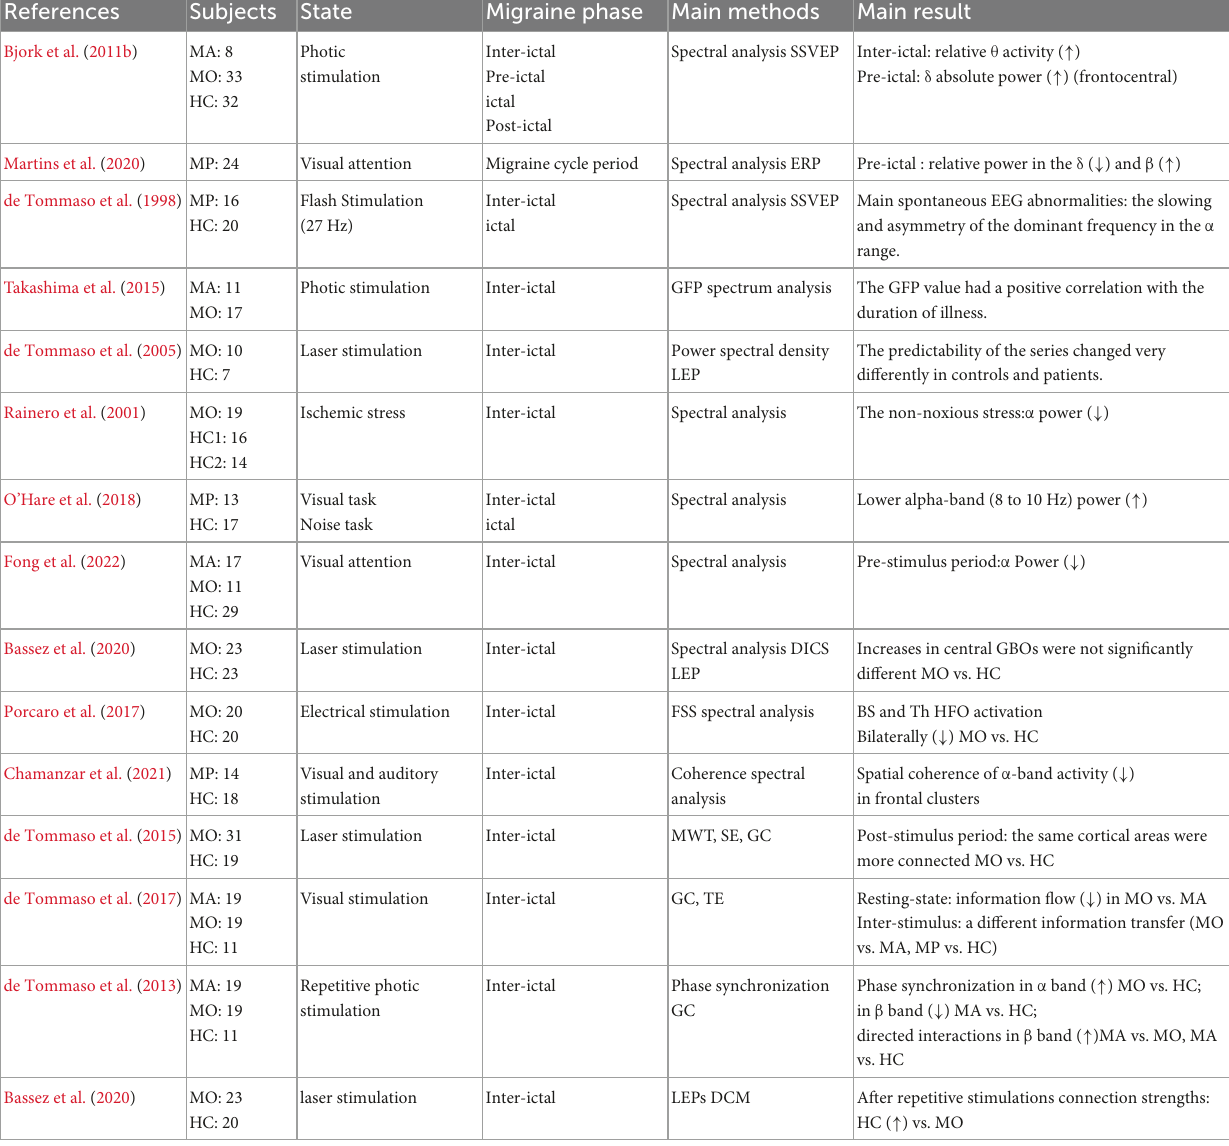
TABLE 2 Summary of Stimulus-state EEG studies in